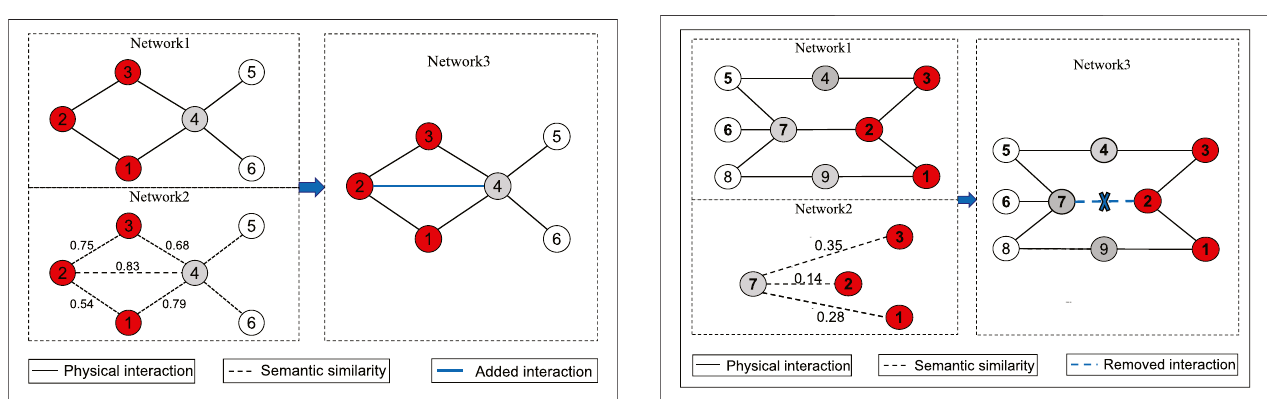
FIGURE 2 | An illustrative example of the suggested removing link operator. Network 1 is the original network, where the red nodes denote disease proteins 1 , 2 and 3 in S , and the gray nodes 4 , 7 , and 9 represent the neighborsofnodesin S ,i.e., NS (cid:1) (4,7,9);Node 7 isaweak-linkednode in NS . Network 2 represents the values of the semantic similarity between 7 and each node in S . Network 3 represents the adjusted network, where the link between nodes 7 and 2 is removed.